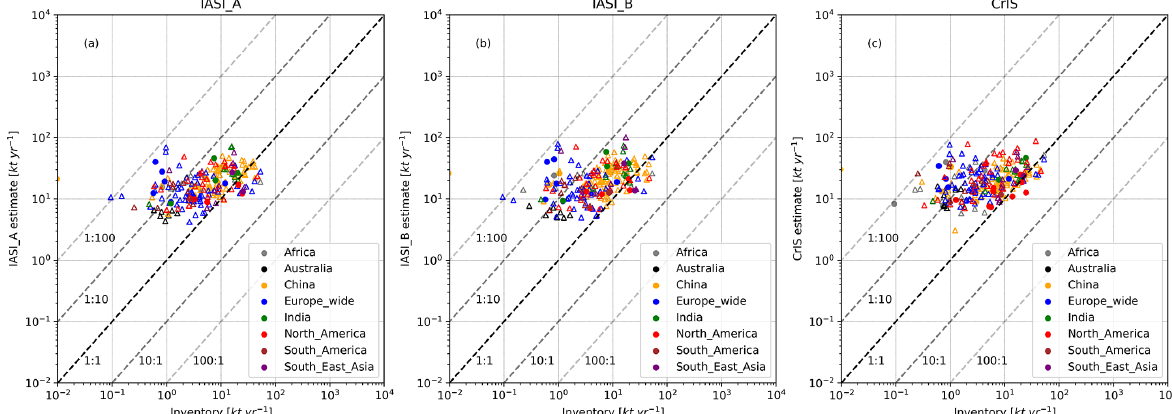
Figure 9. HTAPv2 emission database vs. satellite estimates. HTAPv2 emissions are available globally and the sum of all emissions in a square 1.00 ◦ × 0.50 ◦ (long, lat) surrounding each source location. Open triangles indicate locations with agricultural emissions equal to and above the sum of all other classes in the